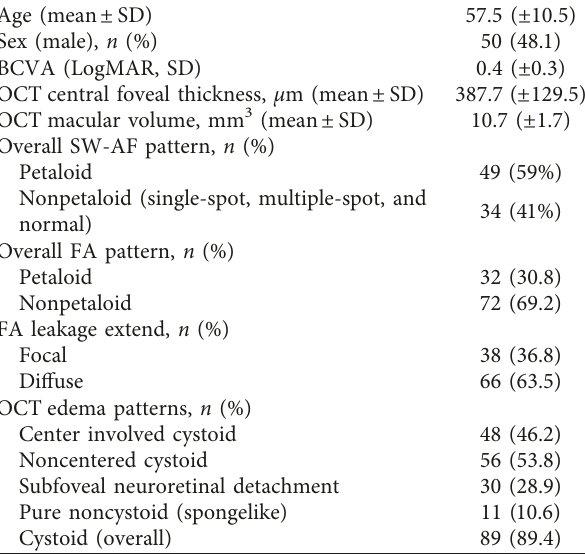
Table 1: General characteristics of patients with